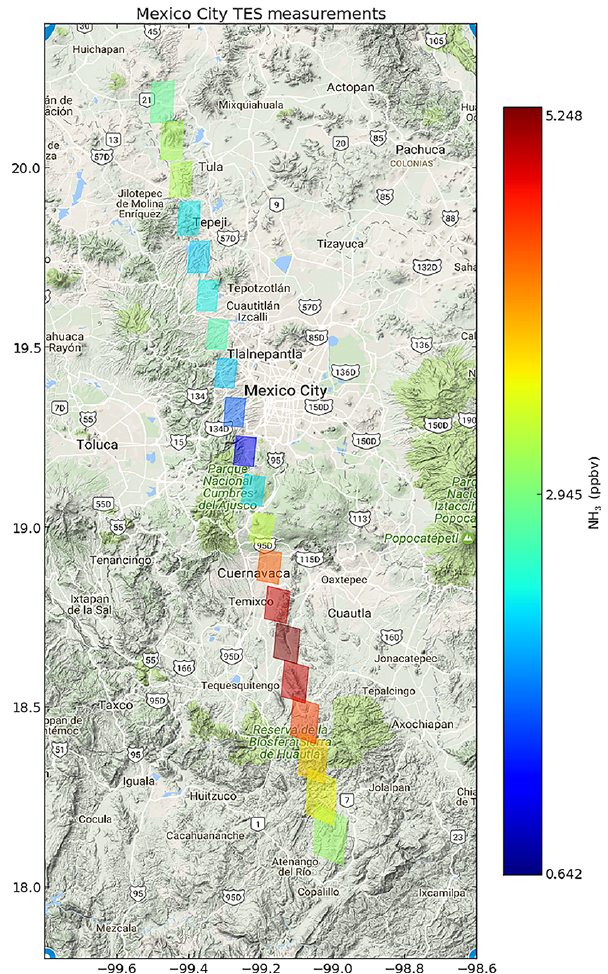
Figure 1. Mean MAM (March–May) TES NH 3 transect over the